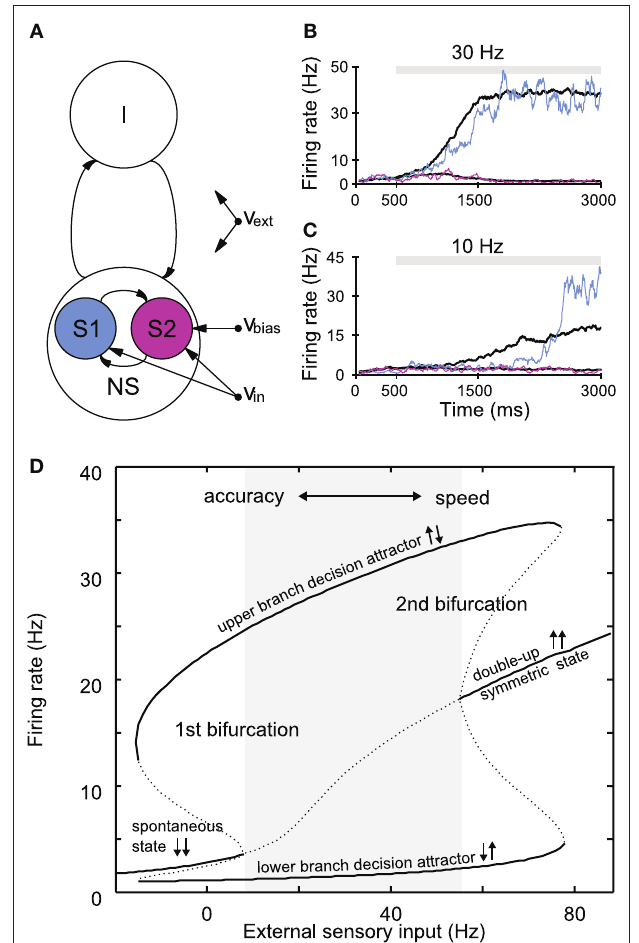
Figure 3 | Attractor network of slow perceptual decision making. (A) Schematic representation of the network, which consists of excitatory and inhibitory spiking neurons, with full synaptic connectivity. All neurons receive external inputs as (poissonian) spike trains characterized by their rate. The excitatory neurons are organized in three pools: the non-specific neurons (NS) and the two selective pools (S1, S2) that receive the inputs encoding each stimulus (with rate ν ). An additional bias ( ν ) can be in bias applied to one of the two selective pools. All neurons also receive an input ( ν ) that simulates the spontaneous activity in the surrounding cerebral ext cortex. (B,C) Single trial (colored traces) and mean firing rate evolution (black) of the selective pools for different inputs. Mean traces are the average over 20 trials for 0% coherence ( ν = 0). (B) In the case of high bias inputs, the transition from the spontaneous state to the decision state is evidence-driven and slow even for single trials. (C) For low inputs, the switch is induced by noise fluctuations, and rather sharp in a single trial. Yet, the mean activity builds up slowly. (D) Stable (solid lines) and unstable (dotted lines) attractor states, dependent on the external sensory input obtained from a mean-field approximation of the network (Brunel and Wang, 2001). The gray area depicts the evidence-driven regime, where the spontaneous state is no longer stable. Increasing the external inputs to both selective populations increases reaction time and decreases accuracy. Thus, a speed–accuracy trade-off might be implemented through the inputs to the neural populations (see text). Left of the first bifurcation, transitions are induced by noise. (B–D) Simulations were performed with a synaptic strength of 1.68 within selective populations; all other parameters were taken from